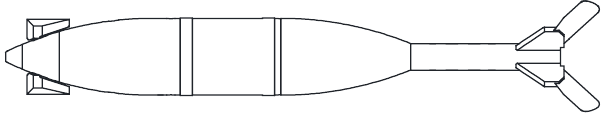
Figure 1: Schematic of the guided mortar projectile.